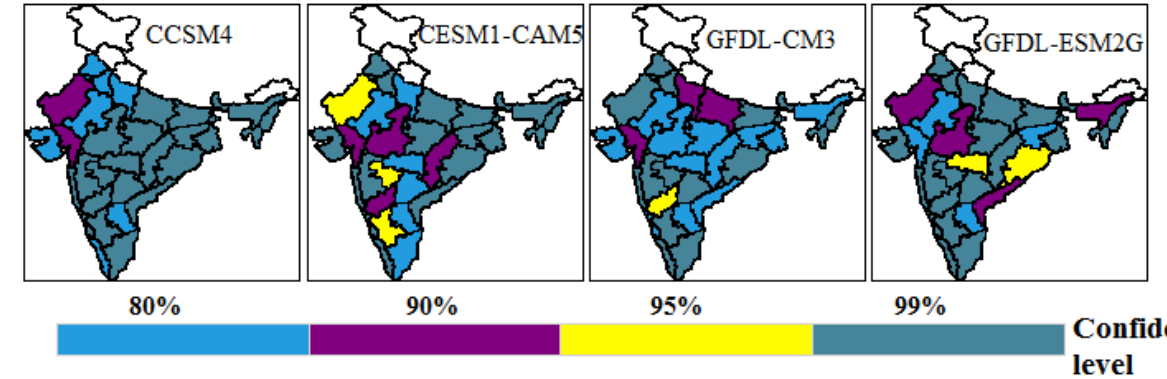
Figure 9. Significant changes in mean at various confidence